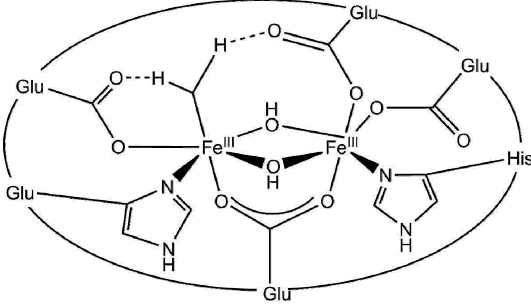
Figure 1. The active site for methane monoooxygenase (redrawn from ref. [81]).